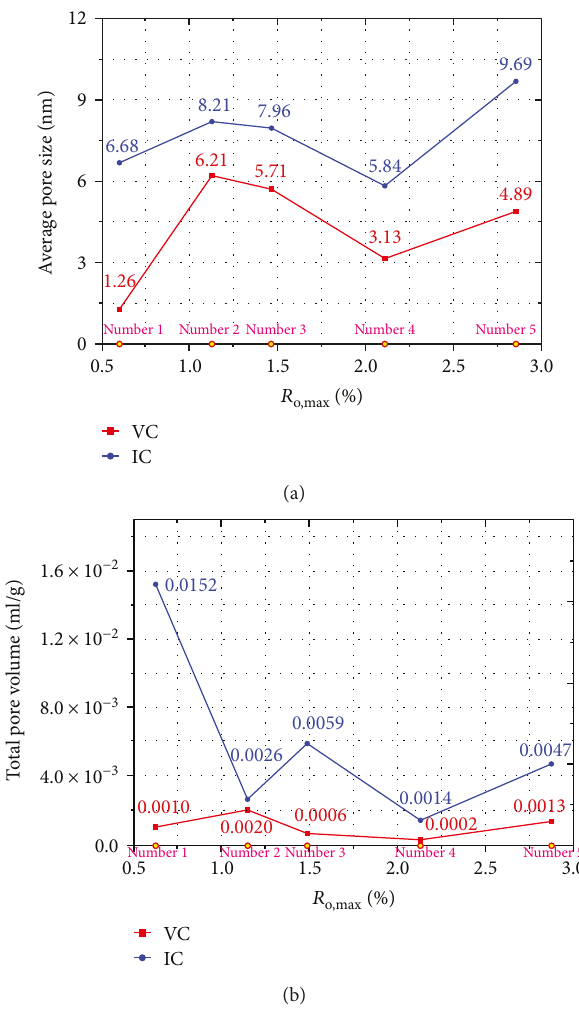
Figure 9: Curves of average pore size (a) and total pore volume (b) for maceral concentrates.